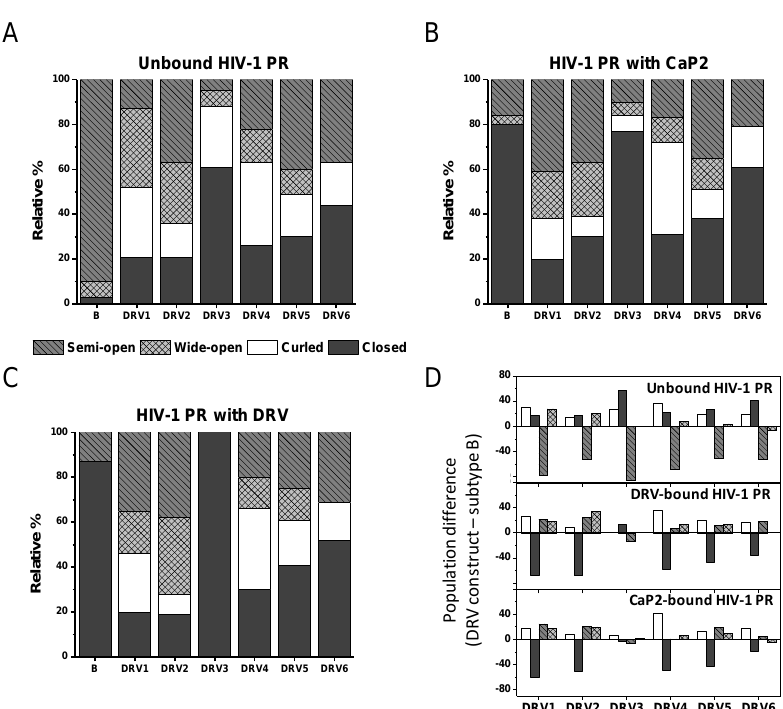
Figure 5. Graphical representation of the relative populations of each of the four conformational states for each HIV-1 PR construct in ( A ) an unbound state, ( B ) addition of the non-hydrolysable substrate analog Ca-P2, and ( C ) addition of inhibitor DRV. ( D ) plots the difference in the population of each state for each DRV construct relative to PI-naïve subtype B.